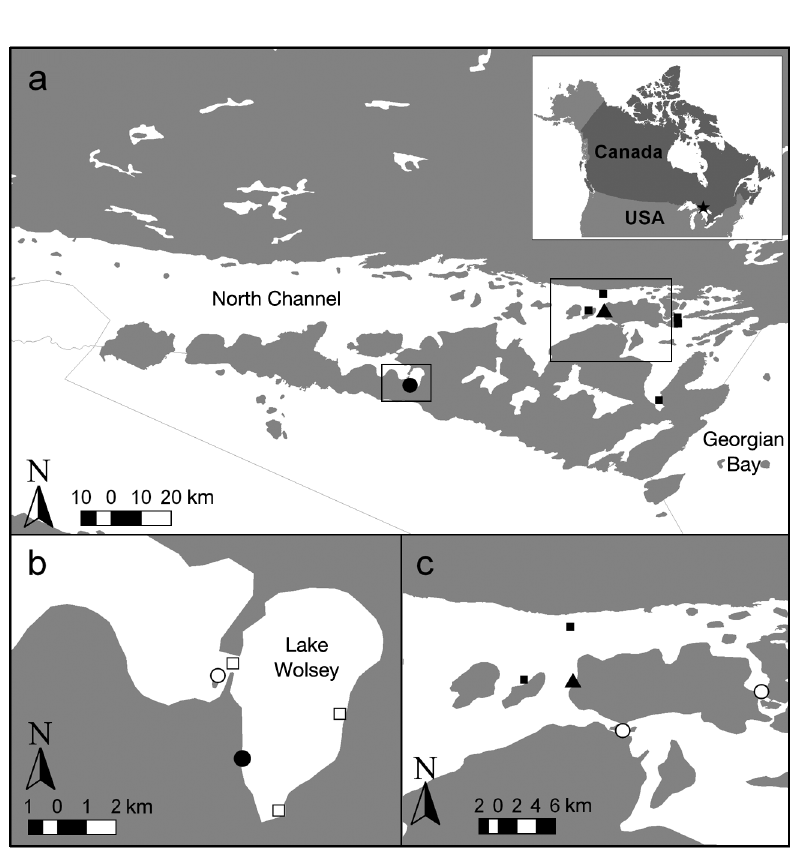
Fig. 1. (a) Study area showing the location of active aquaculture operations around Manitoulin Island (45°48’N, 82°14’W) in the North Channel of Lake Huron, Can- ada. The 2 farms where rainbow trout Oncorhynchus mykiss were released (Farm 1: black triangle; Farm 2: black circle) and nearby aquaculture sites (black squares) are noted. Boxes around farm locations indicate areas shown in detail in lower panels. Locations of radio or acoustic receivers in the vicinity of Farm 2 (b) and Farm 1 (c) are noted (Lotek: open circles; Sonotronics: open